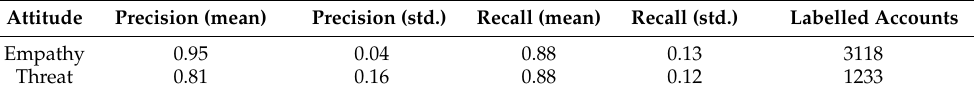
Table 2. Performance (precision and recall) of the user profile classifier based on 10-fold cross-validation. Attitude Precision (mean) Precision (std.) Recall (mean) Recall (std.) Labelled Accounts Empathy 0.95 0.04 0.88 0.13 3118 Threat 0.81 0.16